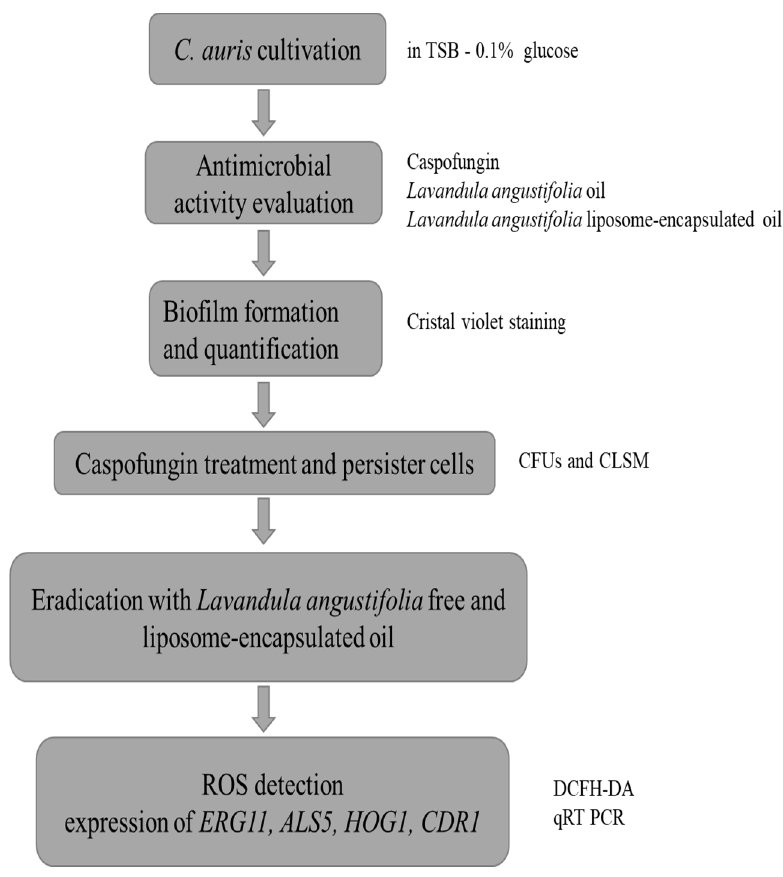
Figure 9. Flow chart of study design .